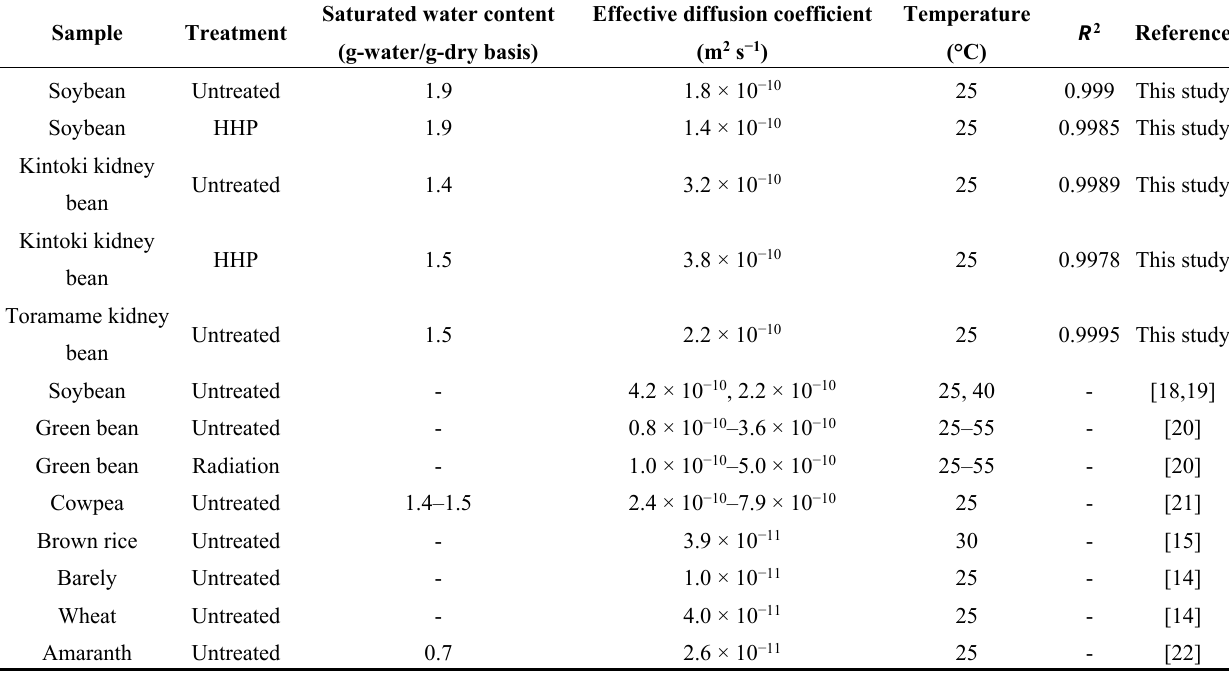
Figure 2. Typical changes in moisture content ( A ) and dimensionless moisture contents ( B ) of untreated control and high hydrostatic pressure (HHP)-treated soybeans. Curves were plotted using Equation (2) for the moisture content, and Equation (3) was used for the dimensionless moisture content. Table 1. Saturated moisture contents and effective diffusion coefficients of soybean, Kintoki kidney bean, and toramame kidney bean in this study. Effective diffusion coefficients of soybean, green bean, cowpea, brown rice, barley, wheat, and amaranth are cited from